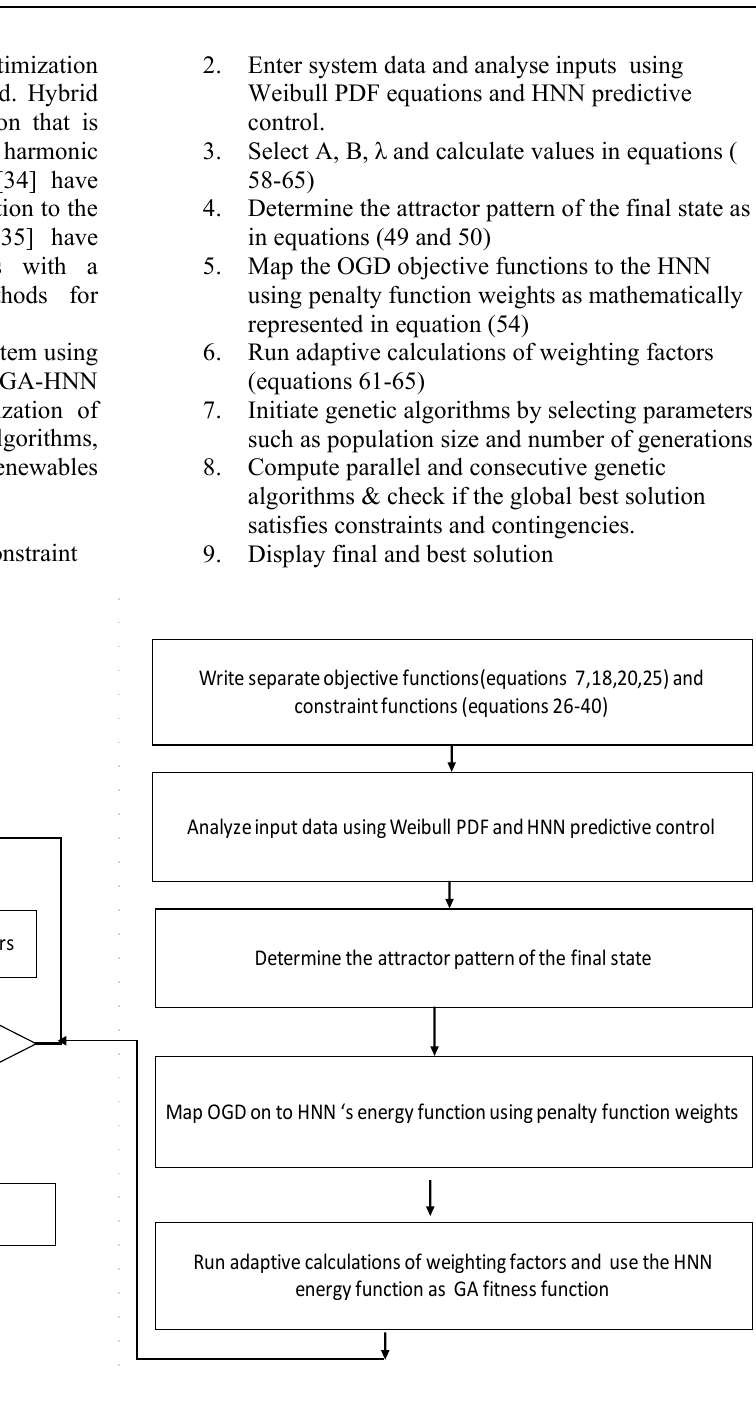
Figure 6. GA-HNN flow